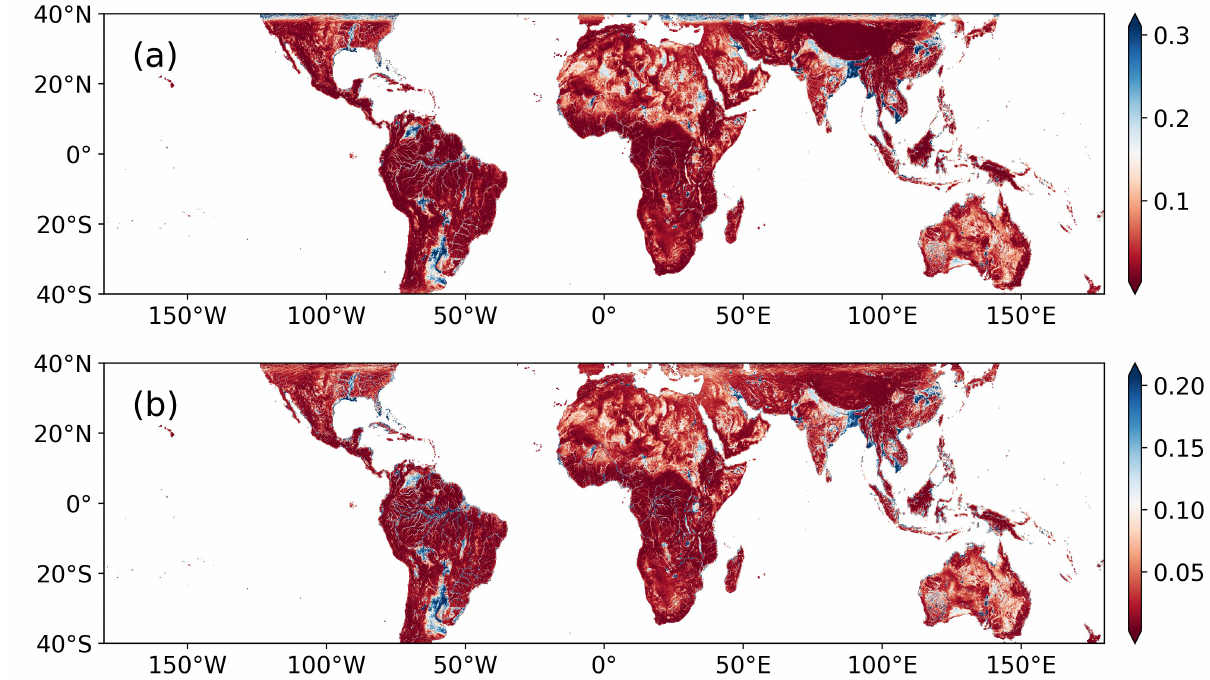
Figure 2. Mean annual value of: (a) Γ mean , (b) Γ std . High values corresponding to water objects are shown in